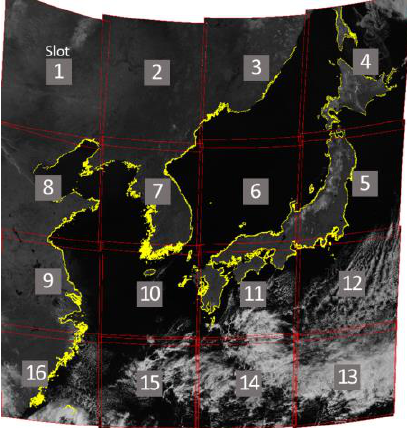
Figure 1. GOCI slots